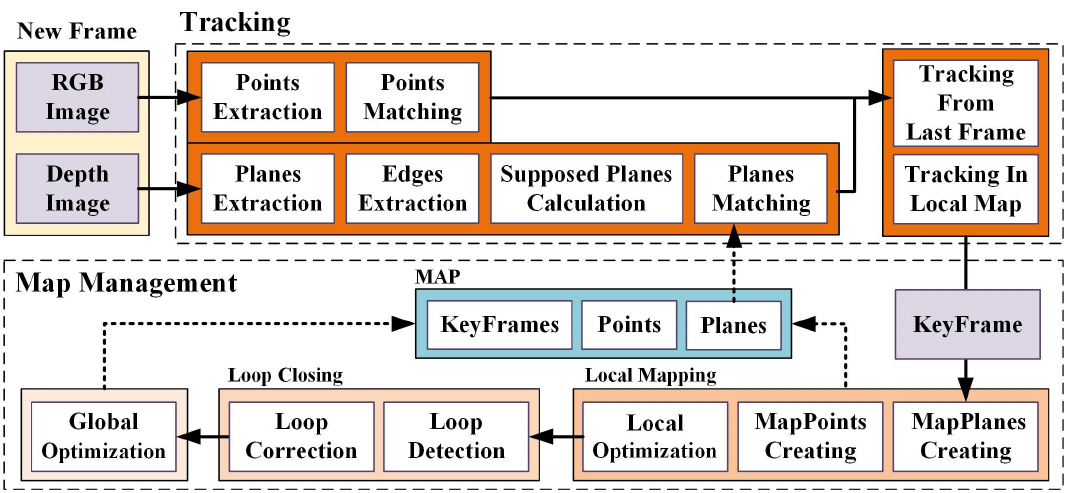
Figure 1. The overview of our proposed point-plane simultaneous localization and mapping (SLAM) using supposed planes from edges: the RGB-D camera provides RGB images and depth images as inputs of the whole SLAM system. The front-end tracks camera pose using matched points and planes. The back-end constructs and updates a consistent map consisting of keyframes, points and